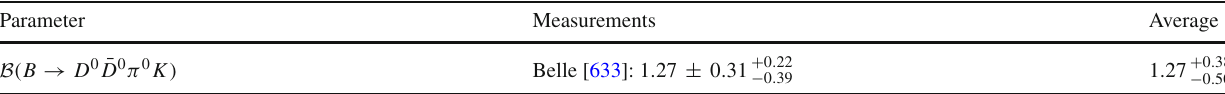
Table 179 B decays to double charm [ 10 − 4